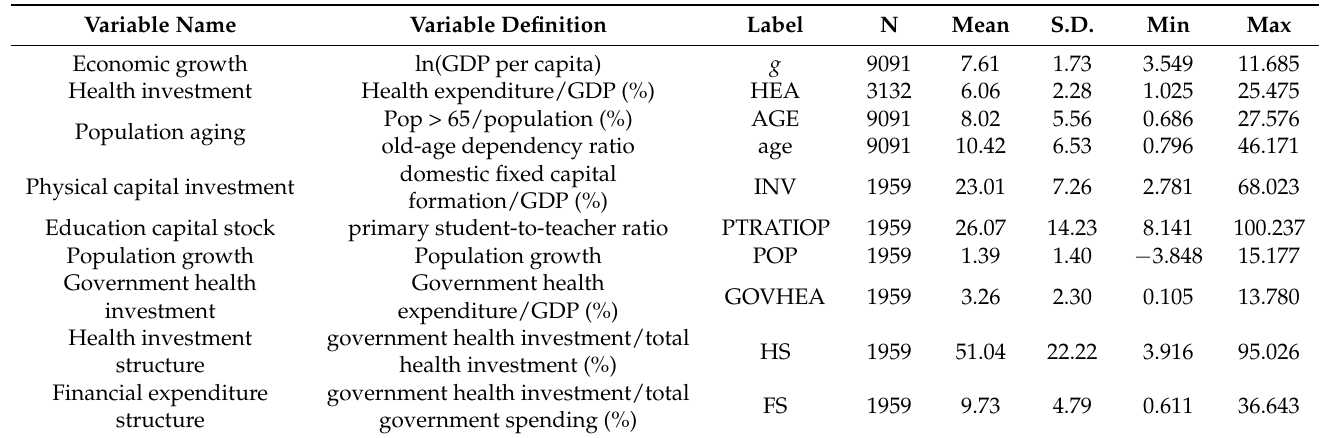
Table 1. Summary statistics of sample data.